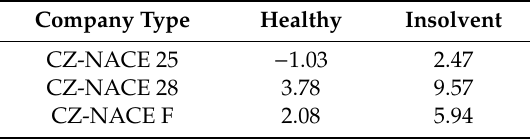
Table 4. Absolute di ff erences of the Ta ffl er model regarding 2012 and 2017 by